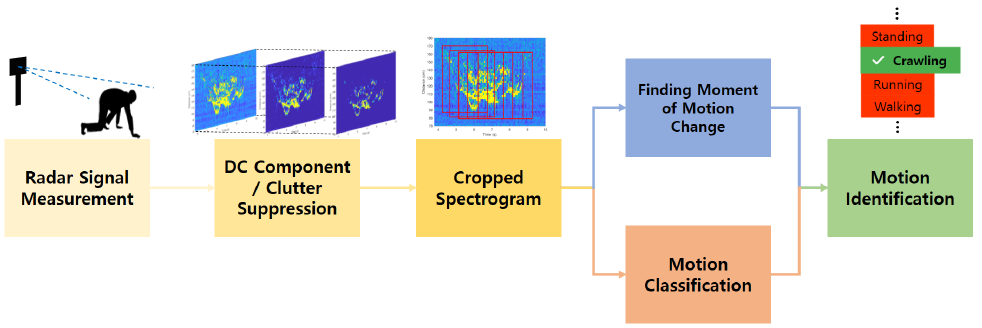
Figure 7. Overall signal processing flow of the proposed